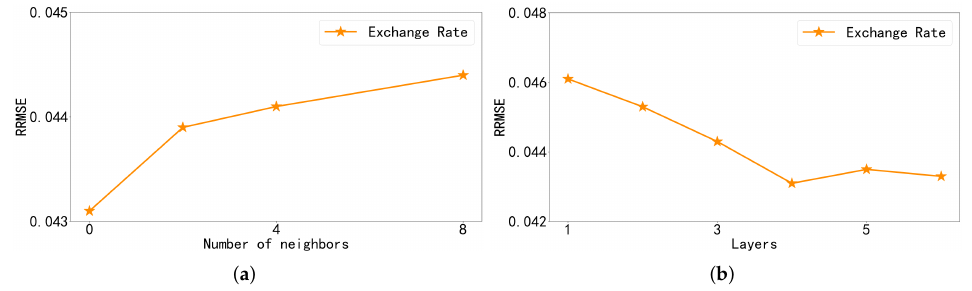
Figure 8. Number of neighbors and Layers parameter analysis in Exchange Rate. Left ( a ) is the RRMSE result of the parameter Number of neighbors taking 0, 2, 4, and 8 respectively, and right ( b ) is the RRMSE result of the parameter Layers from 0 to